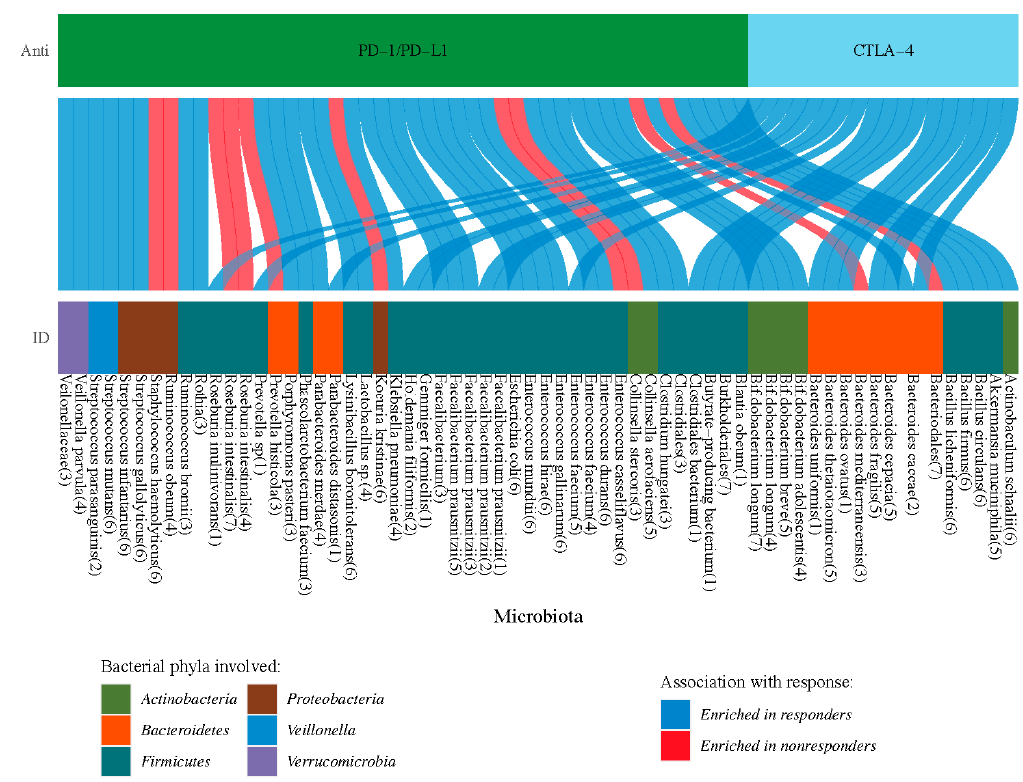
Figure 2. Differences in intestinal microbiota enrichment in ICIs (anti ‐ PD ‐ 1/PD ‐ L1 or anti ‐ CTLA ‐ 4). Sankey diagrams provide visual clues to the enrichment characteristics of microorganisms in different ICIs. Blue band: the bacterial microbiota enriched in patients responding to ICIs, including Akkermansia muciniophila, Bifidobacterium species and Bacillus species, etc. Red band: the bacterial microbiota enriched in patients who did not respond to ICIs, including Staphylococcus haemolyticus, Bacteriodales, and Prevotella histicola, among others. The number in brackets indicates the source of the reference. (1) [87] (2) [92] (3) [10] (4) [94] (5) [100] (6) [90] (7) [109] .